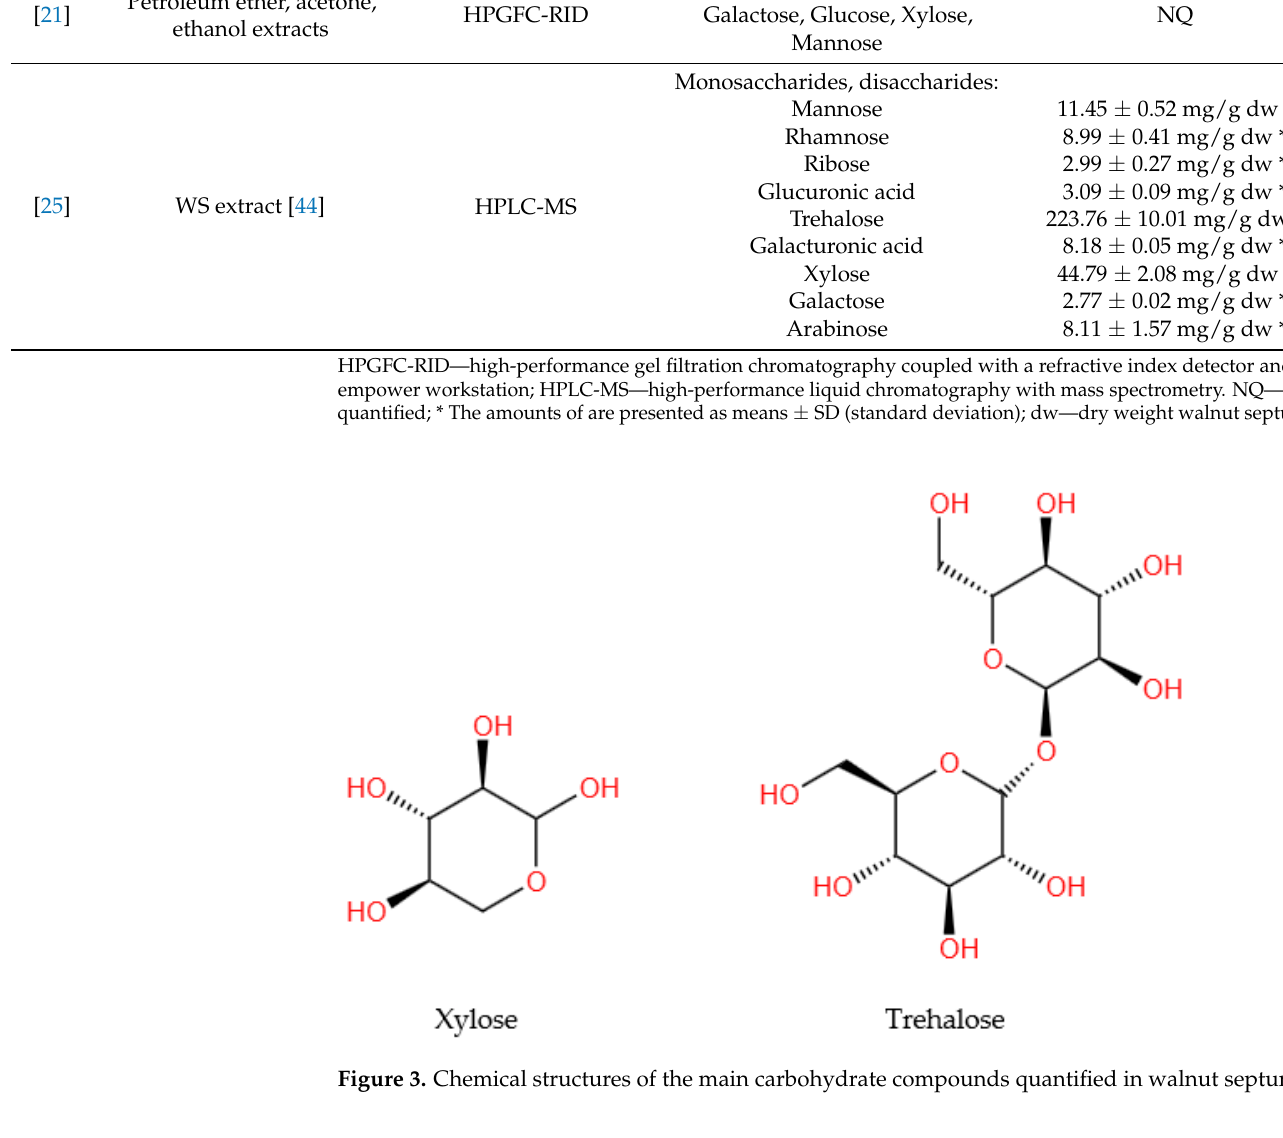
Table 5. Other compounds identified and quantified in walnut septum extracts.